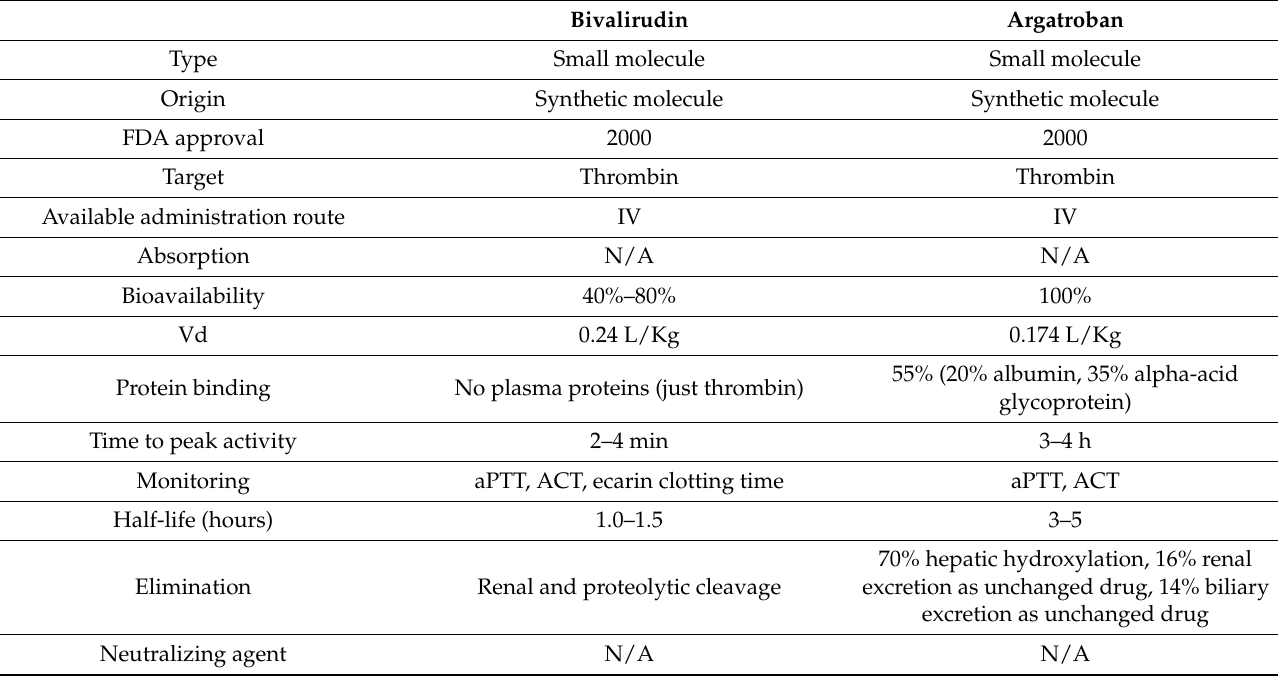
Table 3. Pharmacokinetics of bivalirudin and argatroban. Vd: Volume of distribution, IV: intravenous, aPTT: activated partial thromboplastin time, ACT: activated clotting